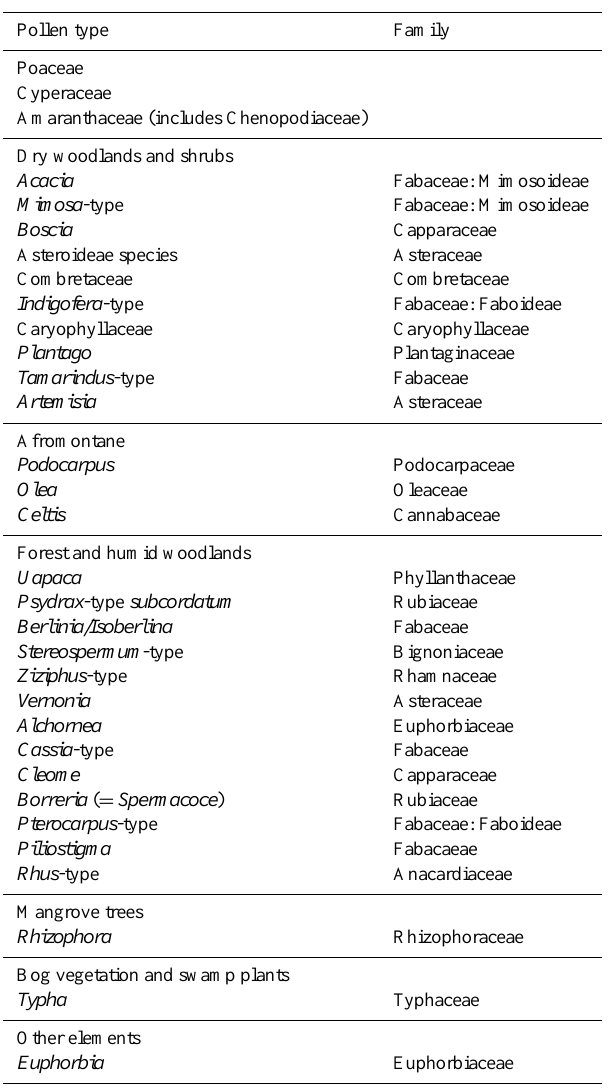
Table 1. List of identified pollen taxa in marine core GeoB12624-1. Taxa are grouped according to their phytogeographical assignment.